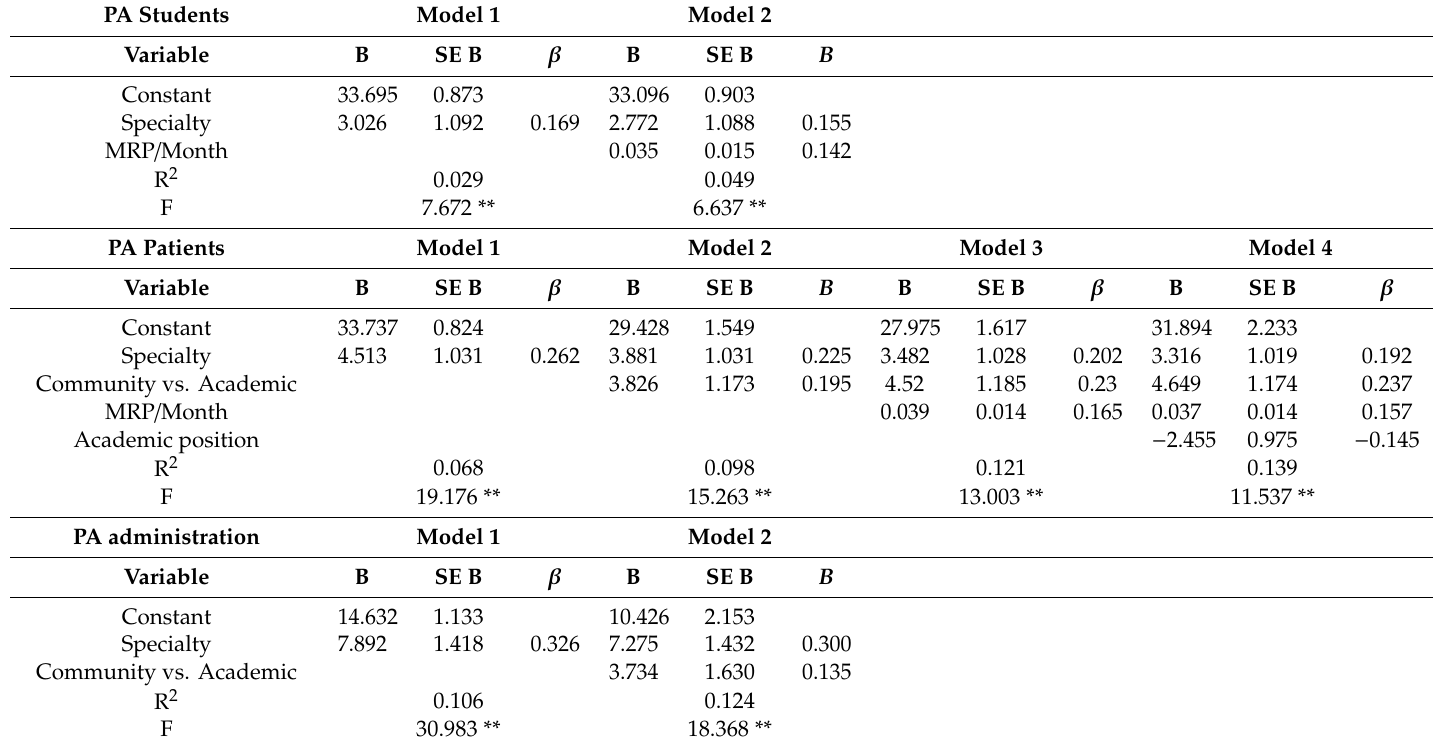
Table A6. Linear Regression for personal accomplishment (PA)